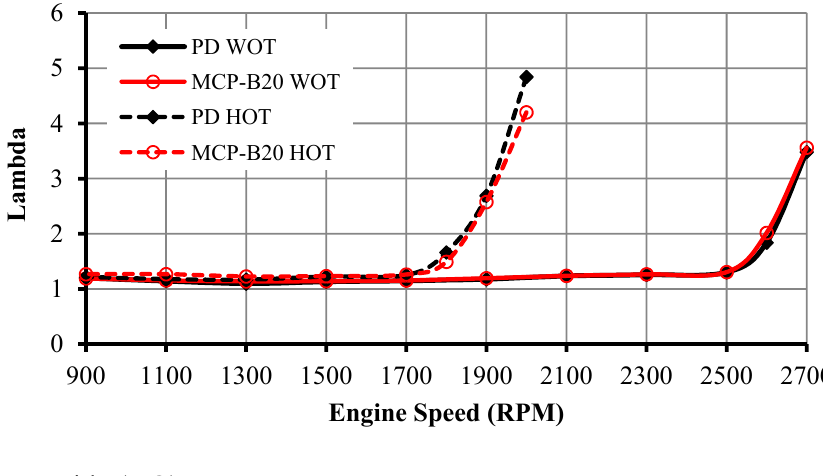
Figure 13. The relationship between tractor engine speeds (RPM) and lambda for PD and